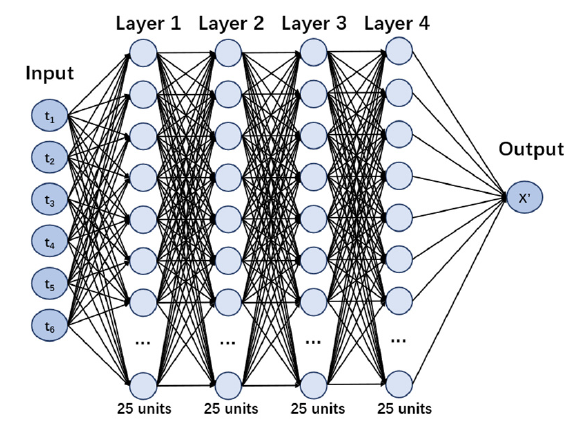
Figure 5. An illustration of a deep neural network.